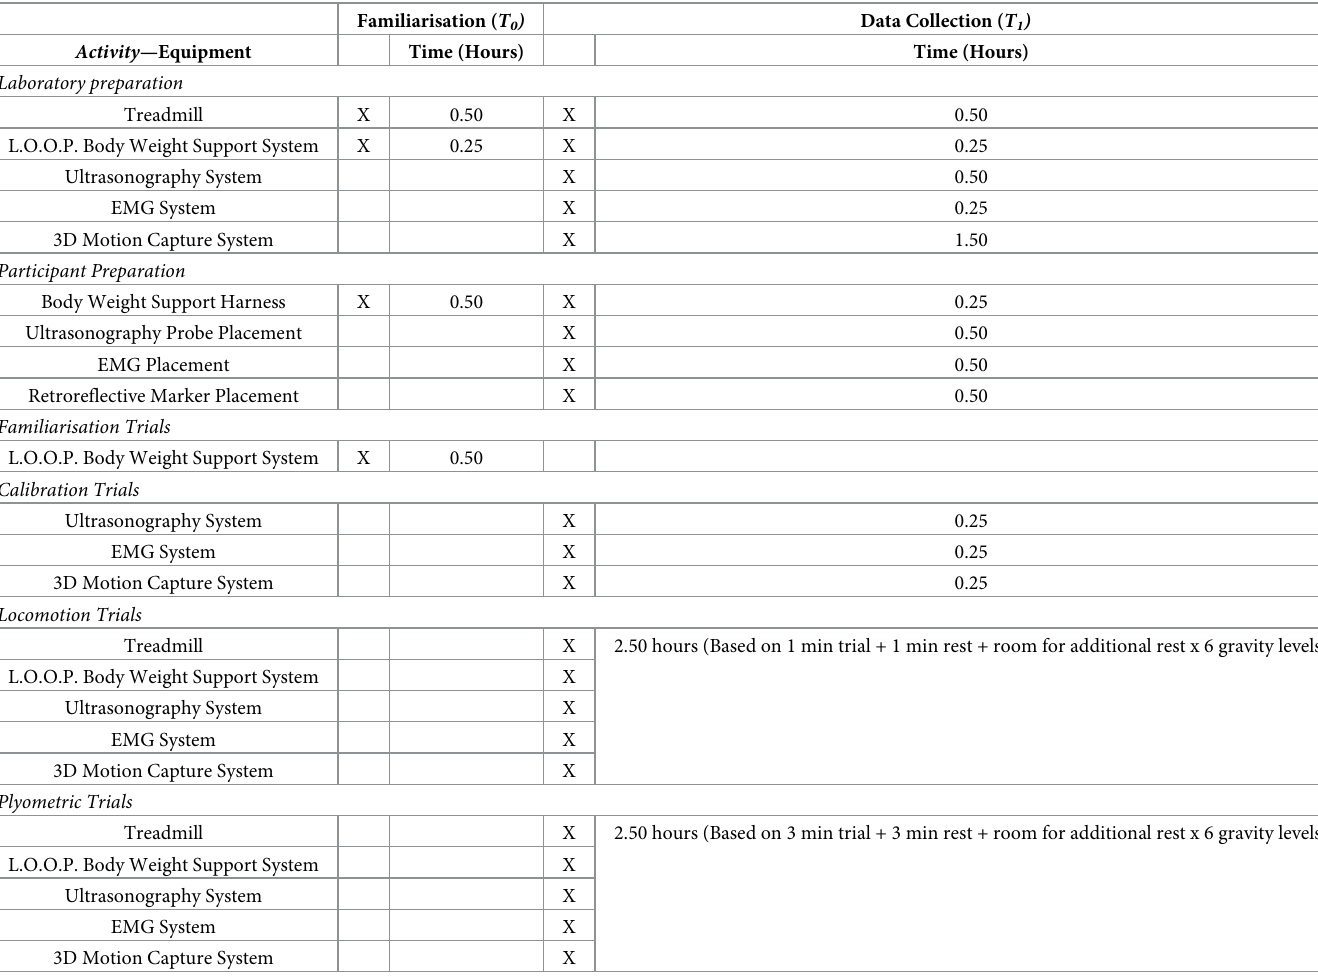
Table 3. Description of the needed equipment and time for each part of the experimental